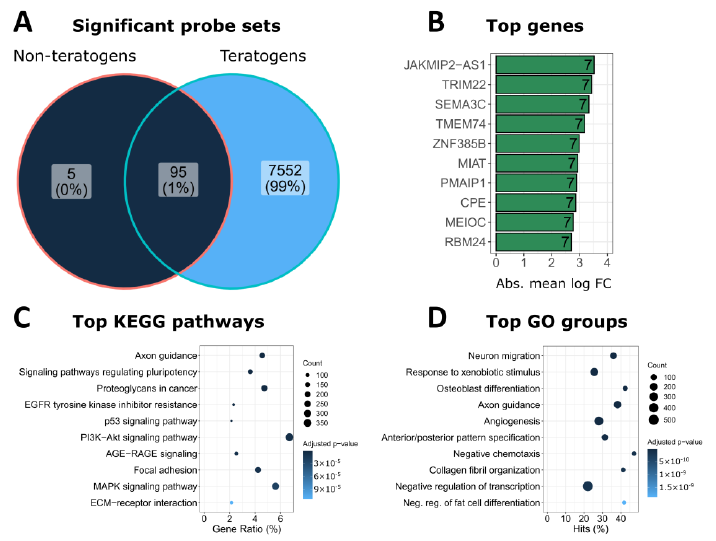
Figure 5. Biological interpretation of genes differentially expressed after exposure of hiPSC to tera- togens at 20-fold C max . ( A ) Number of significant probe sets (log2 fold change > 1; adjusted p -value < 0.05) induced by non-teratogens and teratogens at the 20-fold C max (including also 10-fold C max carbamazepine and 1.67-fold C max VPA). ( B ) Top-10 genes from the 7647 SPS deregulated by terato- gens. The number in the bar indicates the number of compounds that deregulated the specific gene. The absolute mean log2 fold-change of each gene is given on the x -axis. A comprehensive gene list is given in the Supplementary Excel-file 1. ( C ) KEGG pathway enrichment analysis of the 7647 SPS deregulated by teratogens. The ten KEGG pathways with the lowest adj. p -values are given. Full names and complete KEGG-pathway lists are given in the Supplementary Excel-file 2. ‘‘ Count: ’’ number of significant genes from A linked to the KEGG pathway. ‘‘ Gene Ratio: ’’ percentage of sig- nificant genes associated with the pathway compared to the number of all significant genes associ- ated with any pathway. ( D ) The ten GO groups with the lowest adj. p -values from all significantly (adj. p -value < 0.05) overrepresented GO groups in the 7647 SPS deregulated by teratogens. The names of the GO groups have been shortened. Full names and complete GO group lists can be found in the Supplementary Excel-file 3. ‘ Count: ’ number of significant genes from A linked to the GO group. ‘ Hits: ’ percentage of significant genes compared to all genes assigned to the GO group.